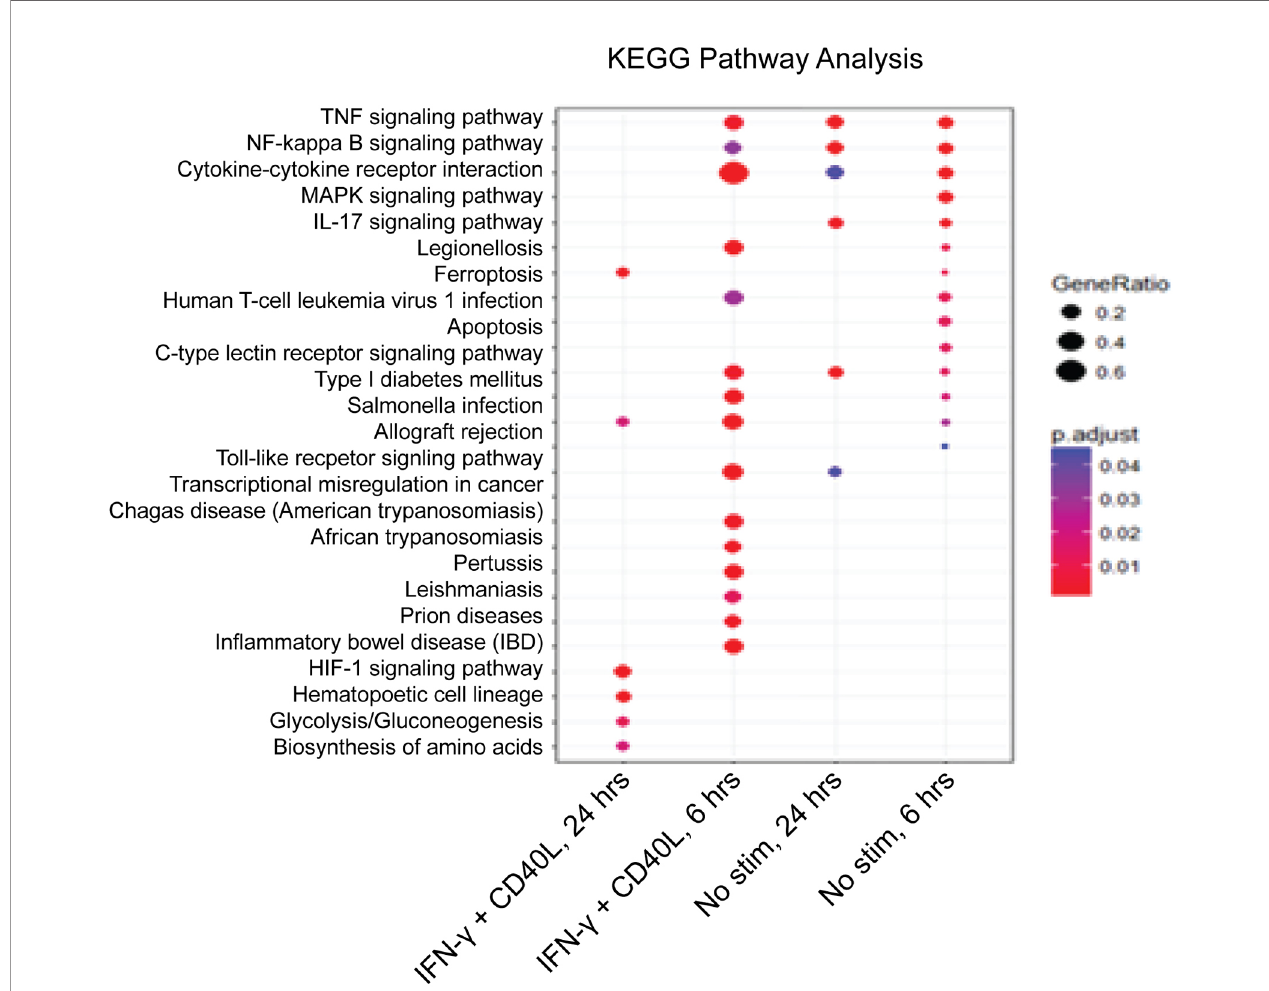
FIGURE 6 | KEGG pathway analysis con fi rms differential gene expression between NFAM1 +/+ and NFAM1 -/- monocytes. Monocytes from 4 NFAM1 +/+ and 6 NFAM1 -/- mice were left unstimulated or stimulated with IFN- g and CD40L. RNA was isolated and analyzed by RNAseq at 6 and 24 hours. Shown is KEGG analysis of genes with increased expression in NFAM1 +/+ monocytes versus NFAM1 -/-